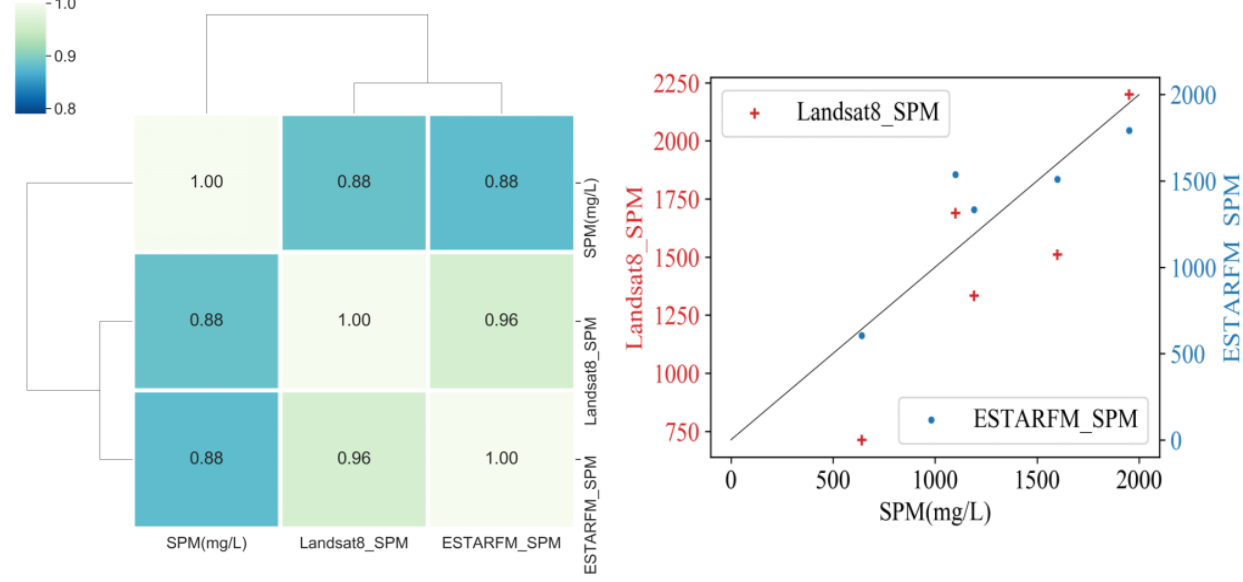
Figure 8. The correlations between Landsat 8 and ESTARFM inversions of SPM and measured SPM